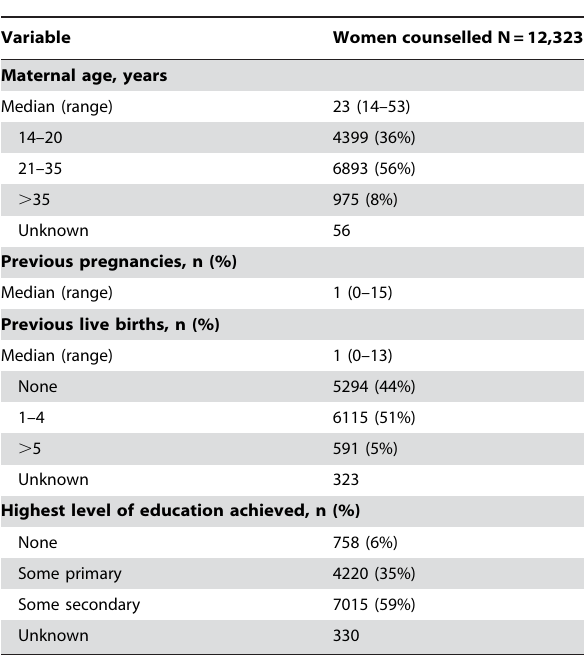
Table 1. Characteristics of pregnant women undergoing counselling for